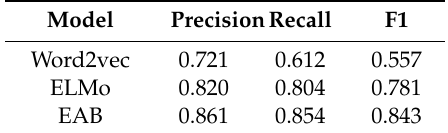
Figure 3. Structure of the sentence similarity model based on EAB. Table 2. Comparison of three algorithms on the CCKS2018 dataset.